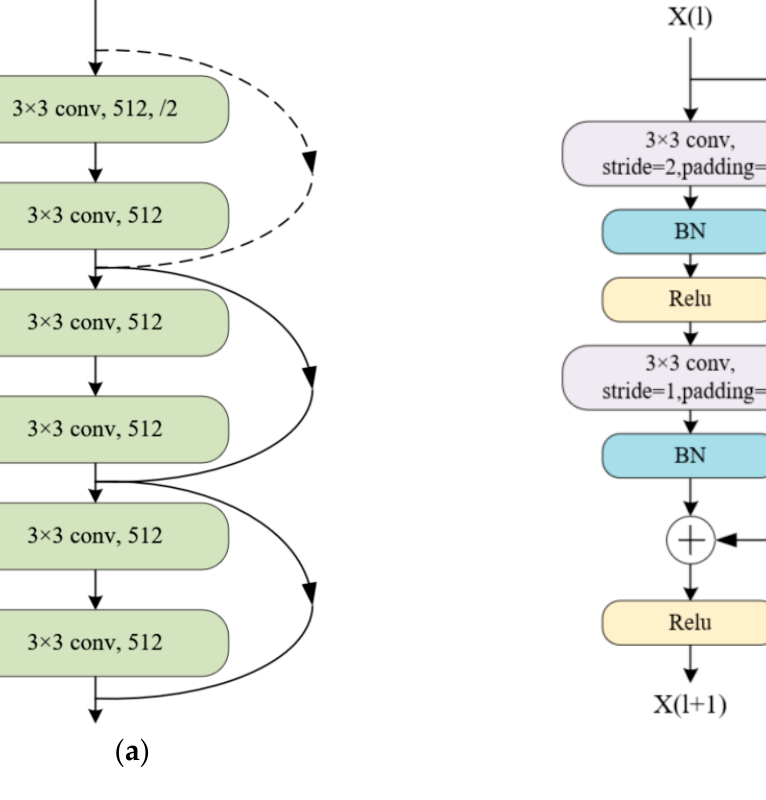
Figure 4. The structure of ResNet: ( a ) The fifth layer network structure of ResNet34; ( b ) Residual block structure corresponding to ( a ).